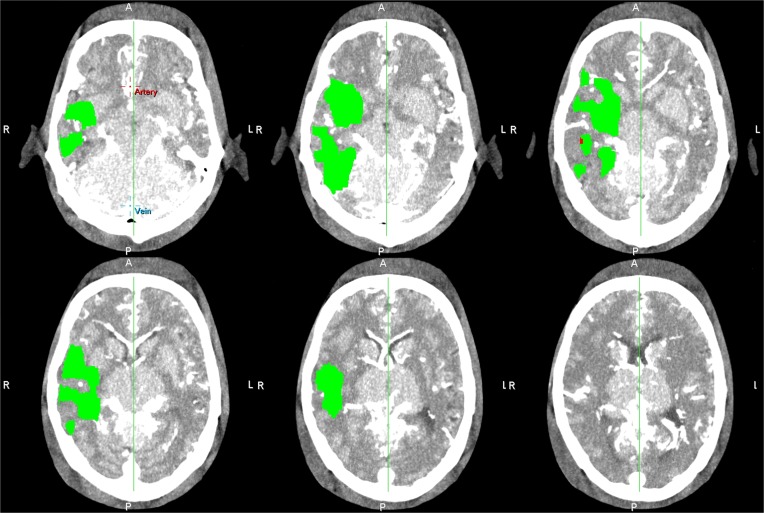
Summary Maps from original phantom data.CTP summary map for all slice locations resulting from analysis of the original CTP phantom data without arrival delay of contrast agent.